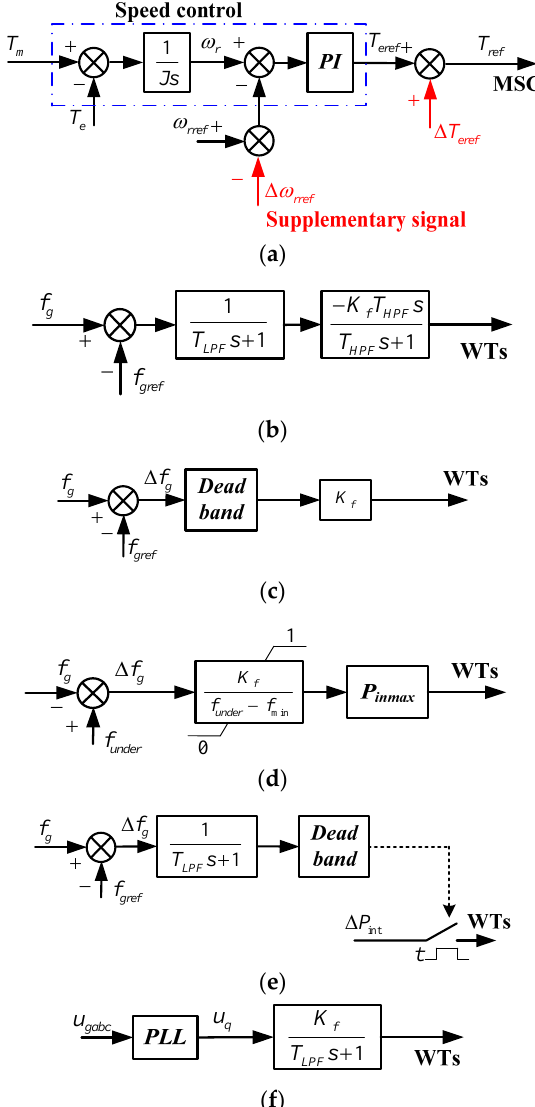
Figure 6. Several inertia controls of WTs based on supplementary signals. ( K f is the gain, T LPF and T HPF are the time constants of filters, f g and f gref are the measured and nominal grid frequency). ( a ) Overall control block of WT’s inertia control based on supplementary signal; ( b ) df/dt method; ( c ) Δ f method.